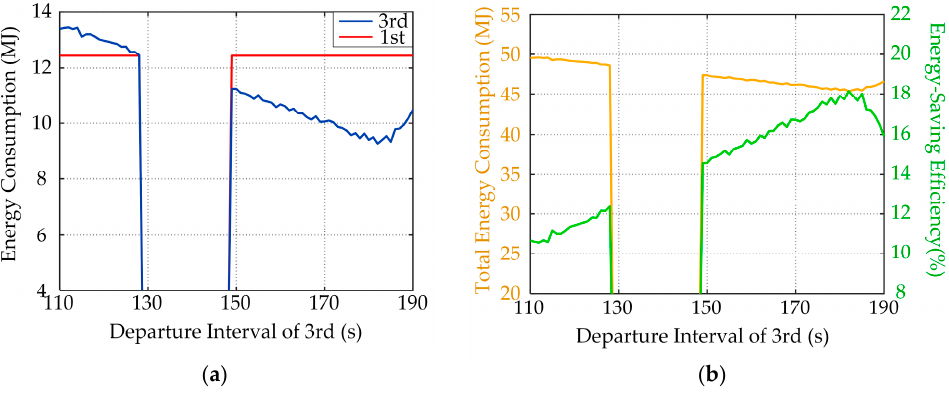
Figure 15. Results under five-mode operation: ( a ) energy consumption of the 1st train and the 3rd train; and ( b ) total energy consumption and energy-saving efficiency.